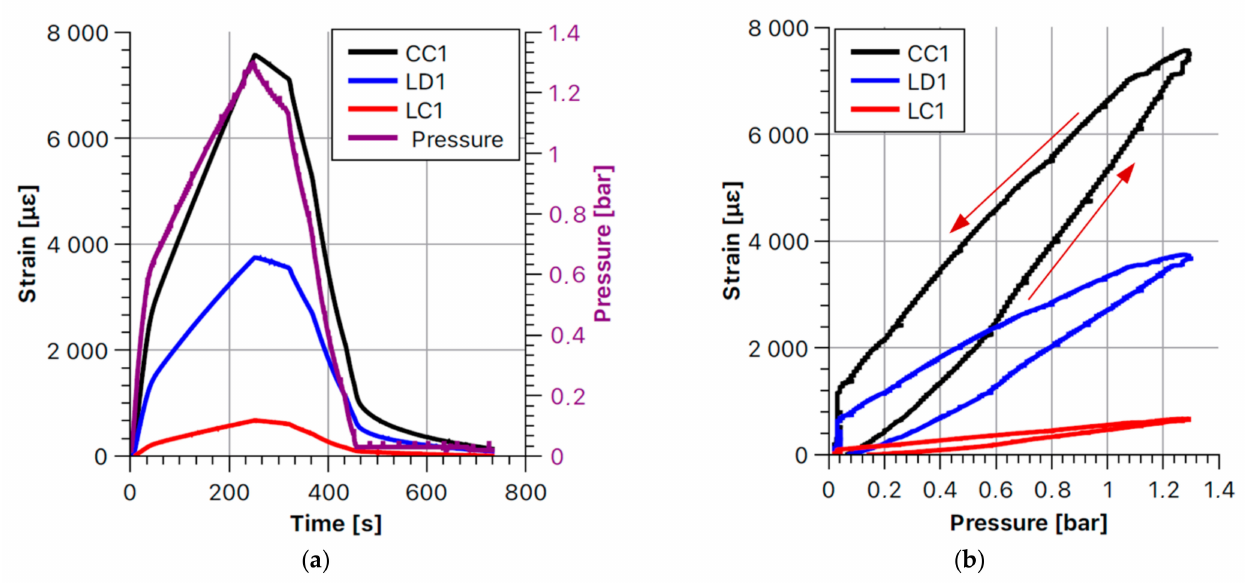
Figure 11. Deformation registered with selected FBG sensors. ( a ) Over time and ( b ) over pressure. Arrows show the direction of pressure increasing/decreasing.